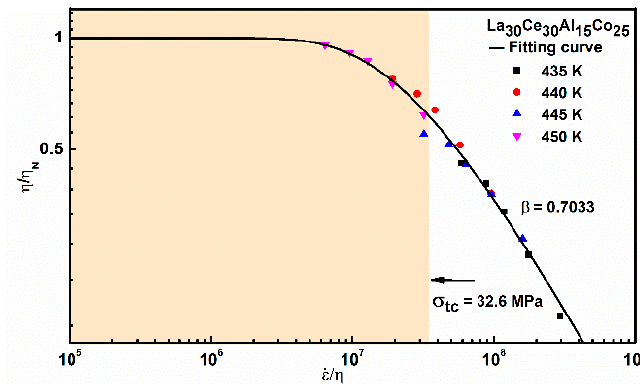
Figure 9. A master curve of La 30 Ce 30 Al 15 Co 25 metallic glass at high temperature tensile deformation between normalized viscosity η/η N and ε(cid:4662)η N. The solid line is fitted by Equation (6).